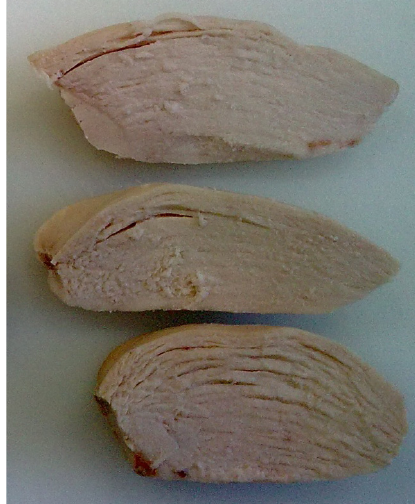
Figure 3. Broiler breast meat with poor